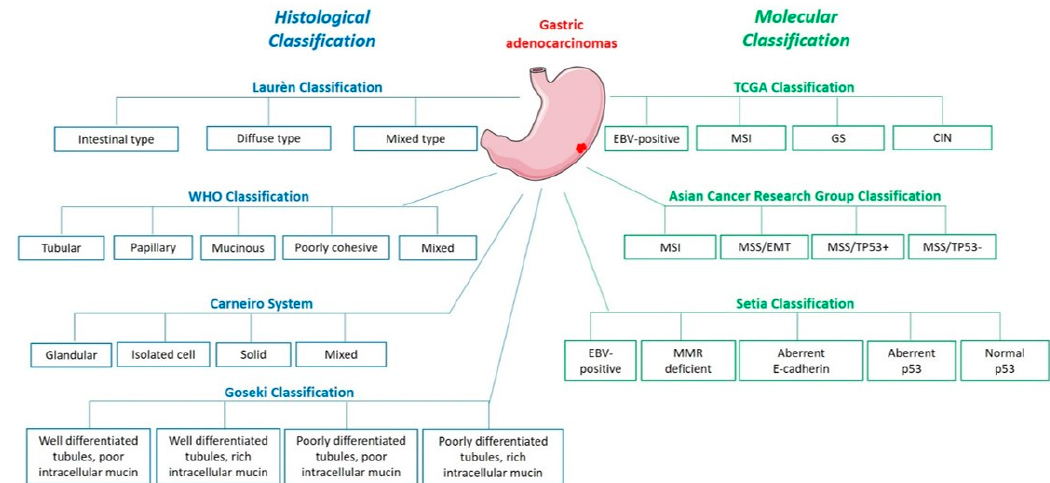
Figure 1. Gastric adenocarcinoma histological and molecular classifications.